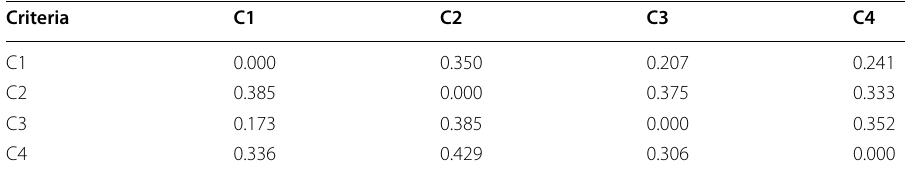
Table 19 Defuzzified relation matrix for revenue sharing model Criteria